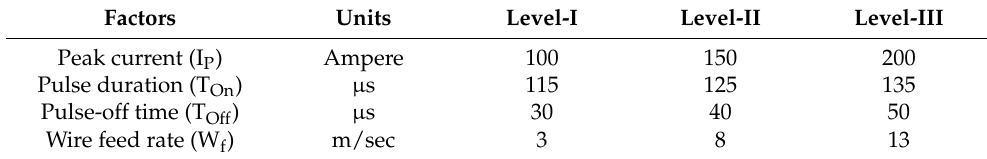
Table 3. Input factors with